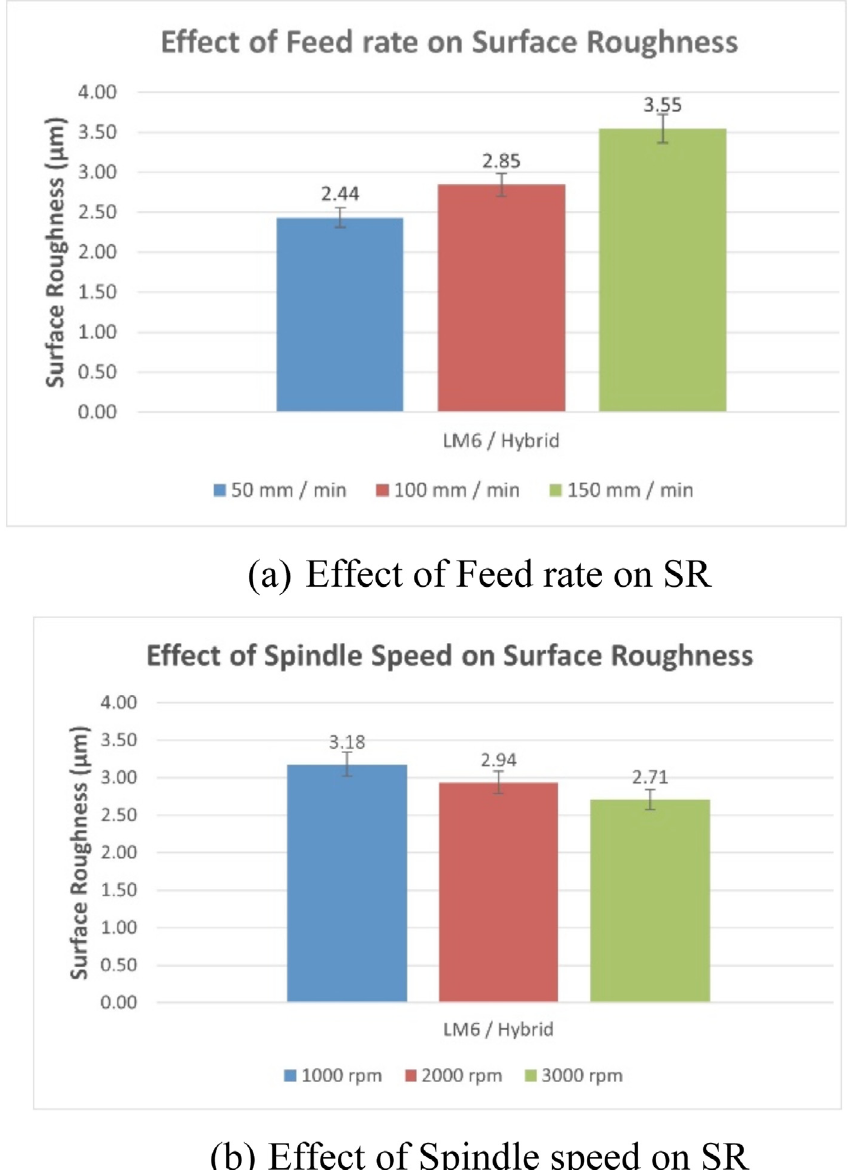
Fig. 10. (a – d) Effect of process variables on